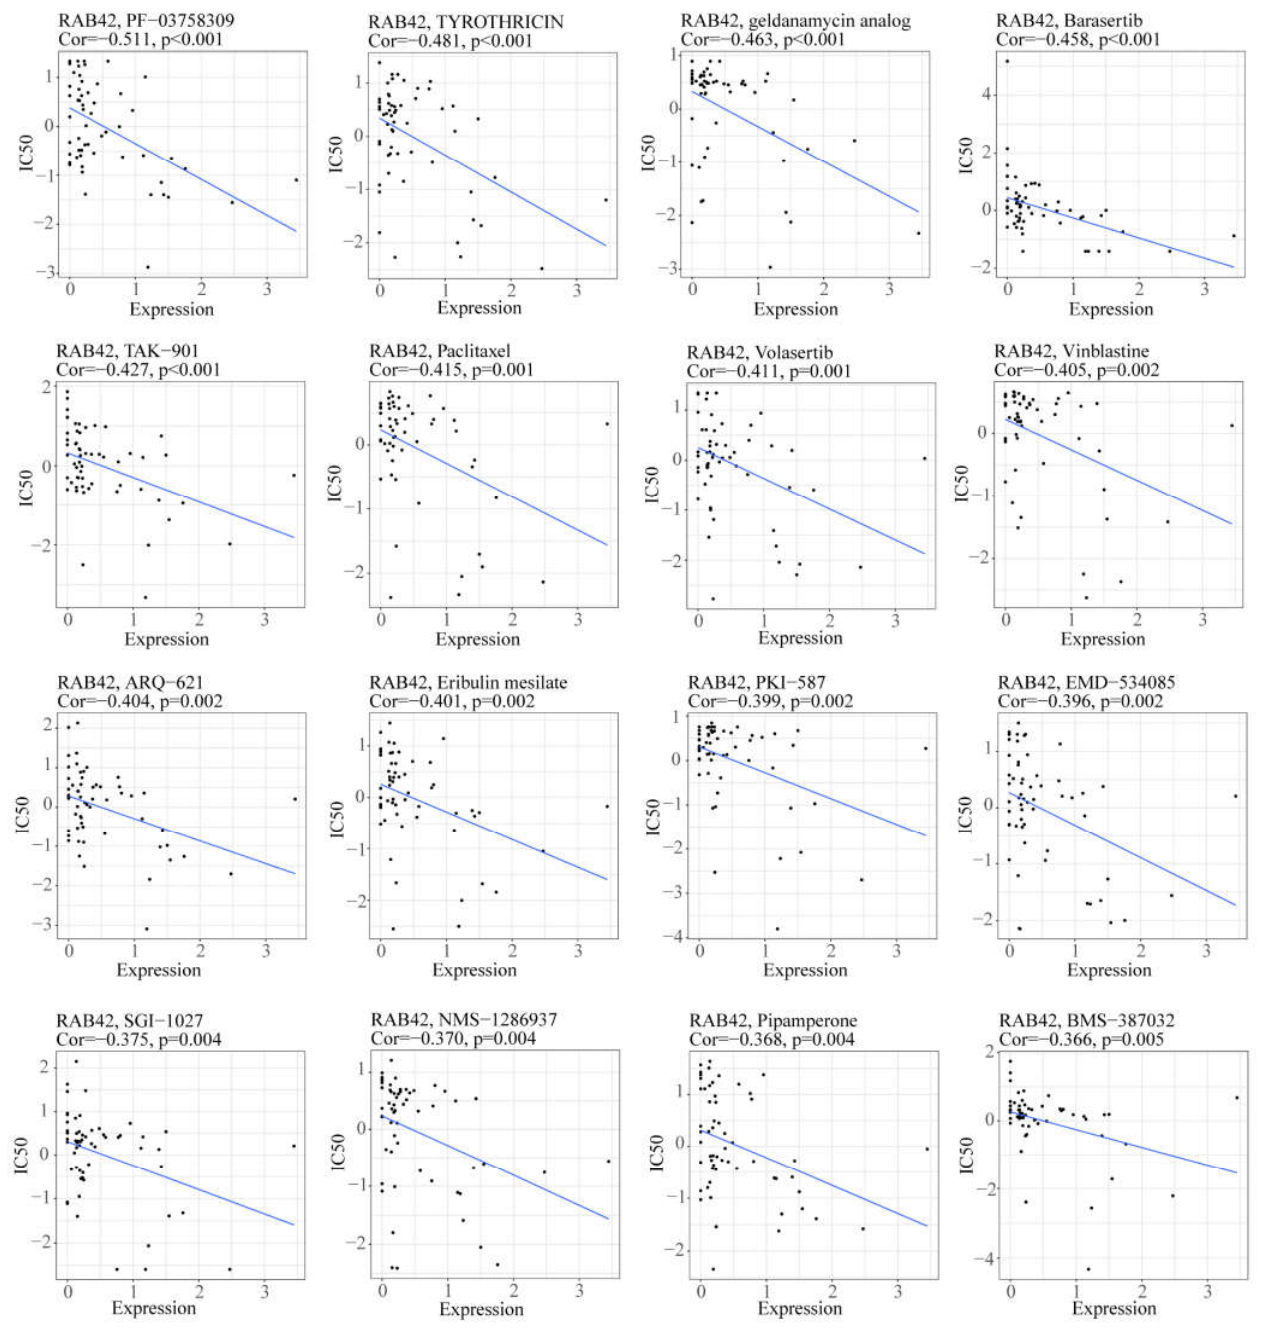
Figure 8. The scatter plots illustrated the correlation between RAB42 expression and IC50 of drugs.